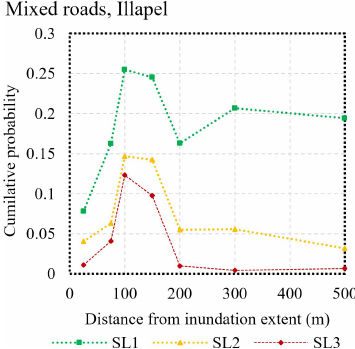
Figure 17. Cumulative probability plot of road service levels com- pared with a distance from the inland extent of tsunami inunda- tion (as an indication of debris density sorting) for the 2015 Illapel tsunami, Coquimbo,